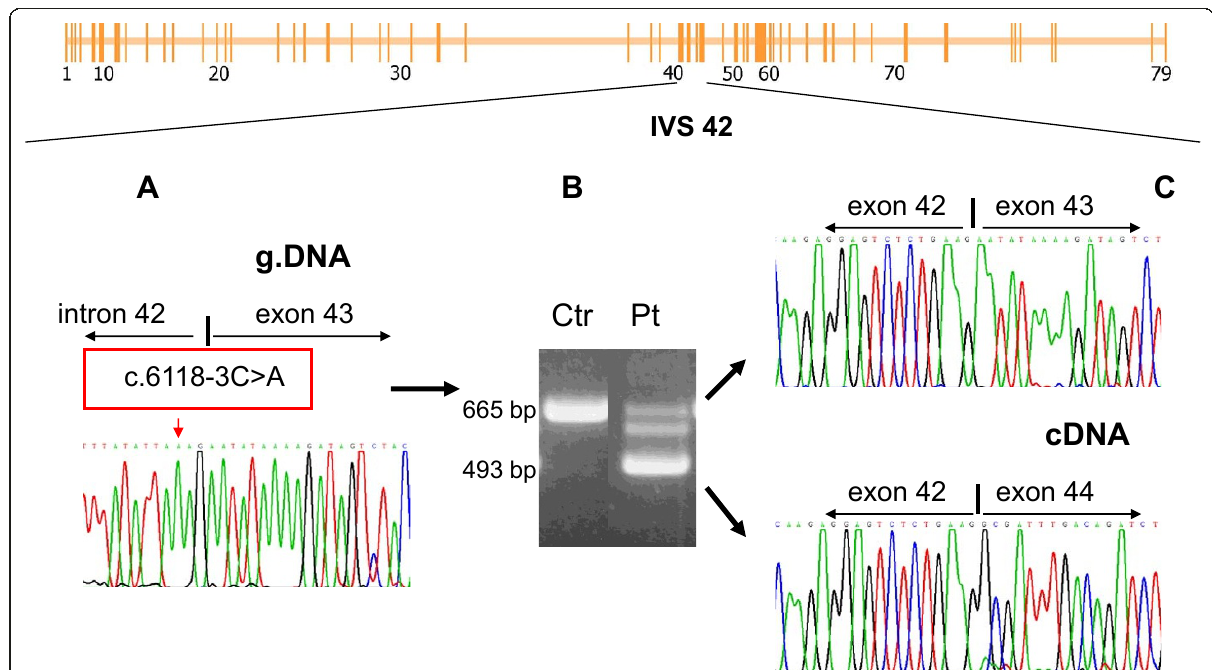
Figure 4 Patient VI: Leaky splice site mutation and double transcript in a BMD patient . The mutation is localized within intron 42 (see schematic representation of the DMD gene reproduced in the upper part of the figure). A. Genomic analysis of the 3 ’ splice site of intron 42 in patient VI. The electropherogram depicts the nucleotide substitution c.6118-3C>A in IVS42 (red box). B. Agarose gel electrophoretic analysis of PCR products derived from the RT-PCR of DMD cDNA nucleotides 5959-6624 form patient VI ’ s muscle-derived cDNA. Transcript analysis reveals the presence of two different RT-PCR products in the patient (Pt): the expected 665-bp full-length band, and a shorter 493-bp band; the RT-PCR product from a control subject demonstrates the presence of the wild-type 665-bp band. C. Sequence analysis of the RT-PCR products demonstrates that the 665-bp band corresponds to the full-length cDNA, while the 493-bp band corresponds to a product carrying the deletion of exon